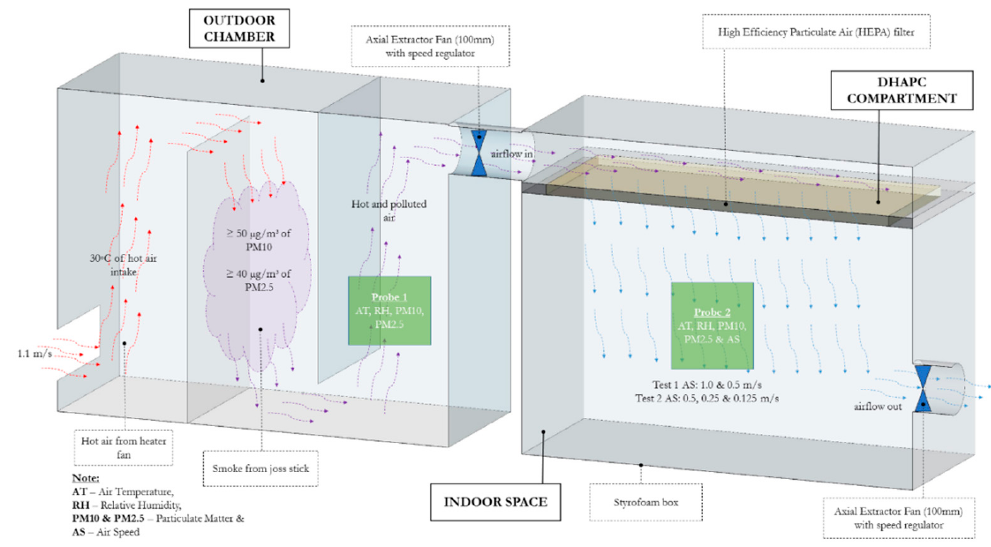
Figure 13. Theoretical dynamic insulation (DI) model concept.